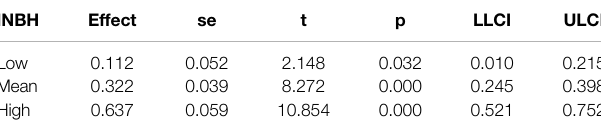
TABLE 5 | Conditional effects of the focal predictor at values of the moderator(s). ENGBH